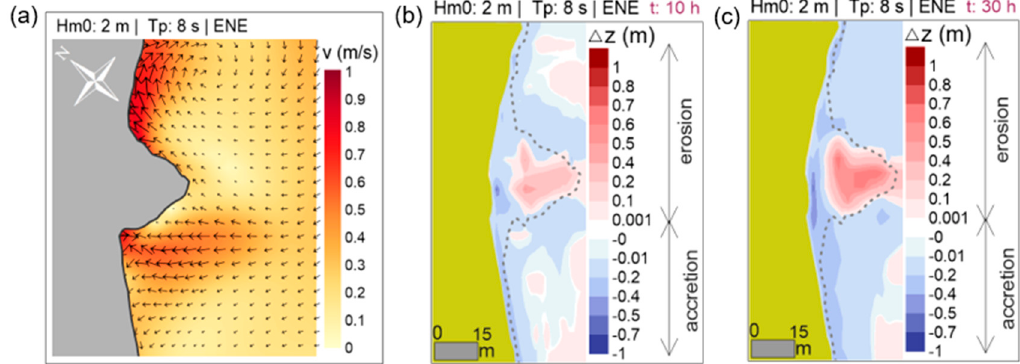
Figure 12. Current field and morphological change of the micro Sand Engine for a ‘Norte’ storm (blue: accretion; red: erosion): ( a ) circulation of wave currents; ( b ) morphological change after 10 h of simulation; ( c ) morphological change after 30 h of simulation.